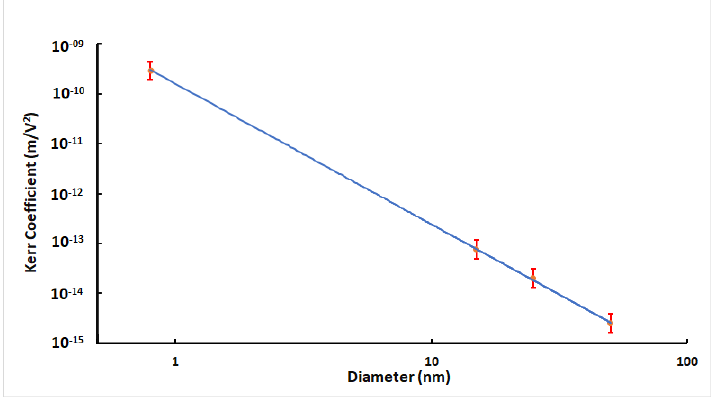
Figure 6. Kerr coefficient correlated with diameter of metallic nanoparticle.